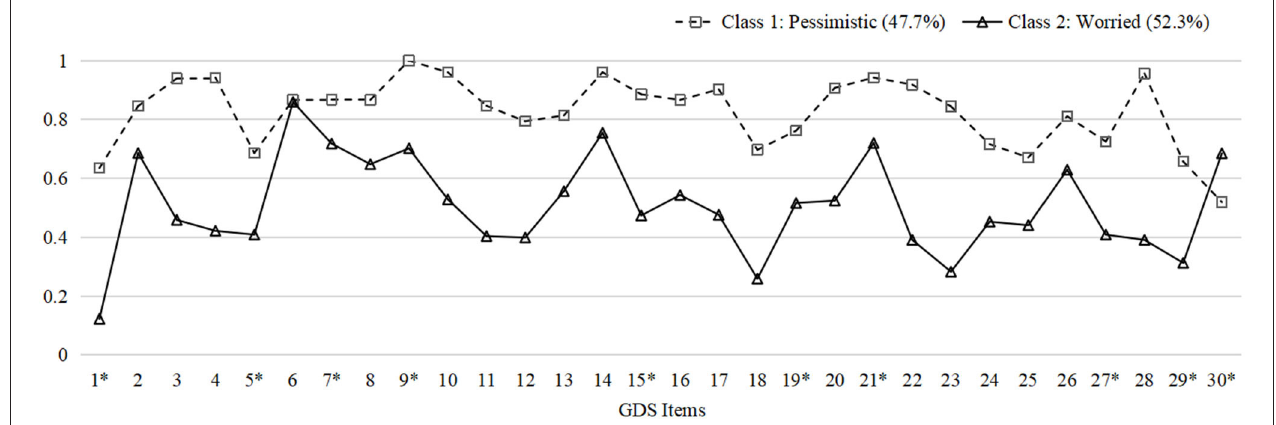
FIGURE 1 | Probability plot of GDS items in two classes. The plot indicates the probabilities of endorsing every item in GDS within each latent group. Y-axis: Probabilities. X-axis: 1. Satisfied*; 2. Dropped activities and interests; 3. Empty; 4. Bored; 5. Hopeful*; 6. Bothered by thoughts; 7. Good spirits*; 8. Afraid something bad is going to happen; 9. Happy*; 10. Helpless; 11. Restless; 12. Prefer to stay at home; 13. Worry about the future; 14. Memory problems; 15. Wonderful to be alive*; 16. Downhearted; 17. Worthless; 18. Worry about the past; 19. Find life exciting*; 20. Hard to get started; 21. Full of energy*; 22. Hopeless; 23. Think most people are better off; 24. Upset; 25. Crying; 26. Have trouble concentrating; 27. Enjoy getting up*; 28. Avoid social gatherings; 29. Easy to make decisions*; 30. Clear mind* (*: Reverse coding). GDS, Geriatric Depression Scale.